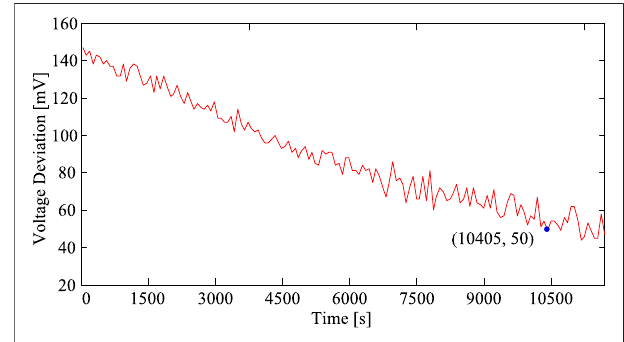
FIGURE 7 | Voltage deviation of six cells during the charging process with a static acceleration coef fi